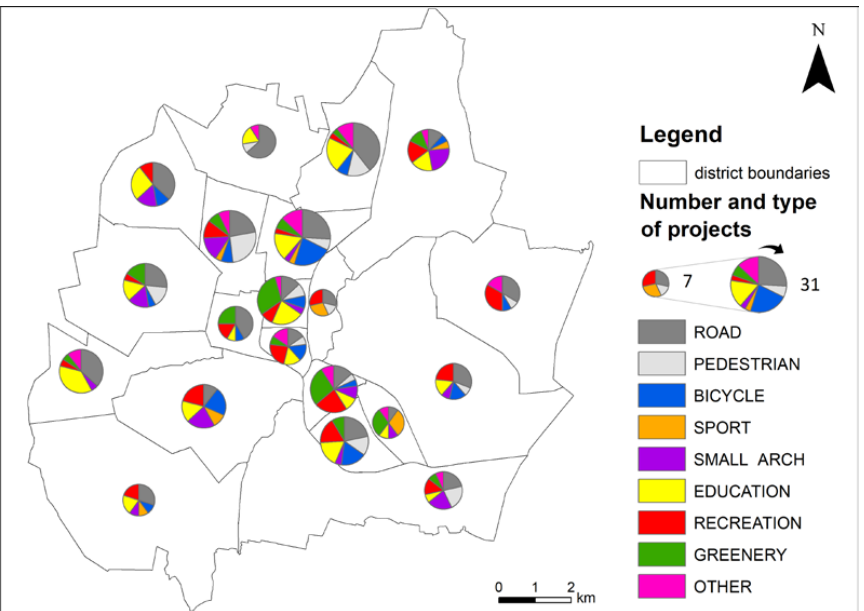
Figure 5. The number and structure of the types of analyzed district projects accepted for imple-